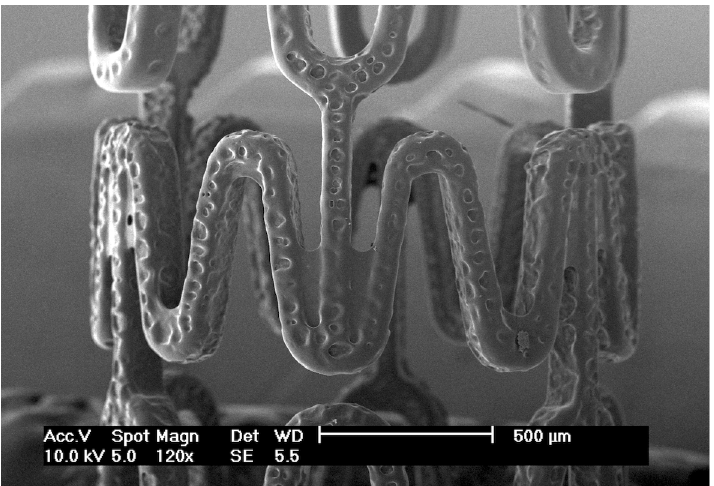
Fig 6. SEM image of a stent coated with large electrosprayed droplets (dia. ~120 μ m). A non-uniform coating with large pores was observed on the stent due to dewetting of the liquid coating caused by ineffective evaporation and solidification of the deposited droplets during coating